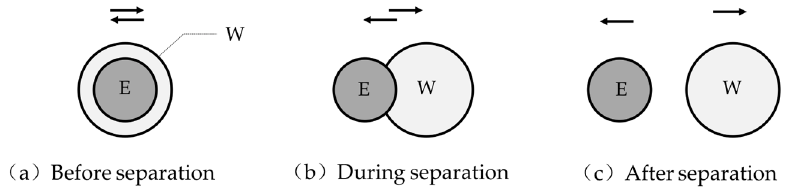
Figure 7. The relationship separation process of the elders with the external world. Note: *E = The elders; W = The external world.